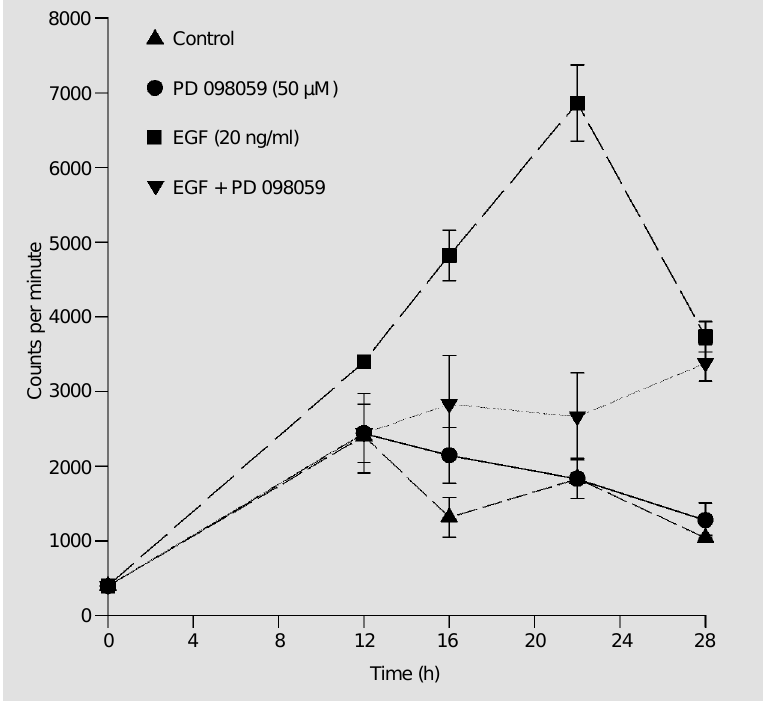
Figure 1 - Effect of PD 098059 on epidermal growth factor (EGF)-induced DNA synthesis. Postconfluent, quiescent C3H 10T1/2 cells were switched to Dulbecco’s modified Eagle’s medium (DMEM) containing 0.1% fetal bovine serum (FBS) 24 h prior to T = 0 h when